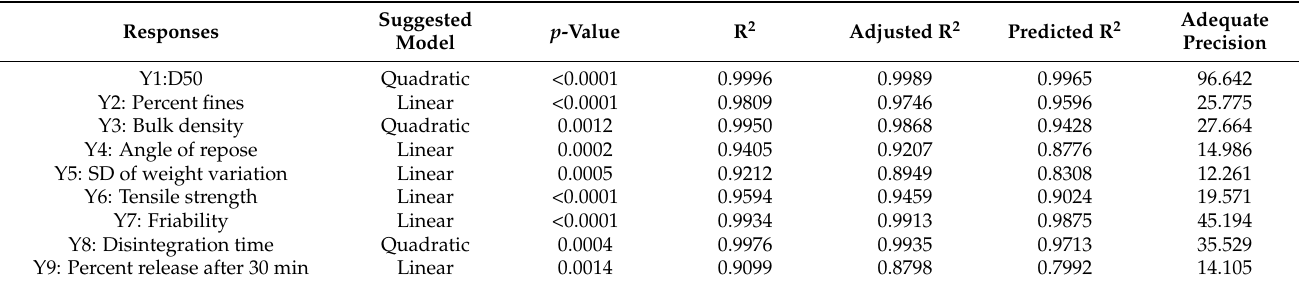
Table 4. Summary of model fitting and statistical